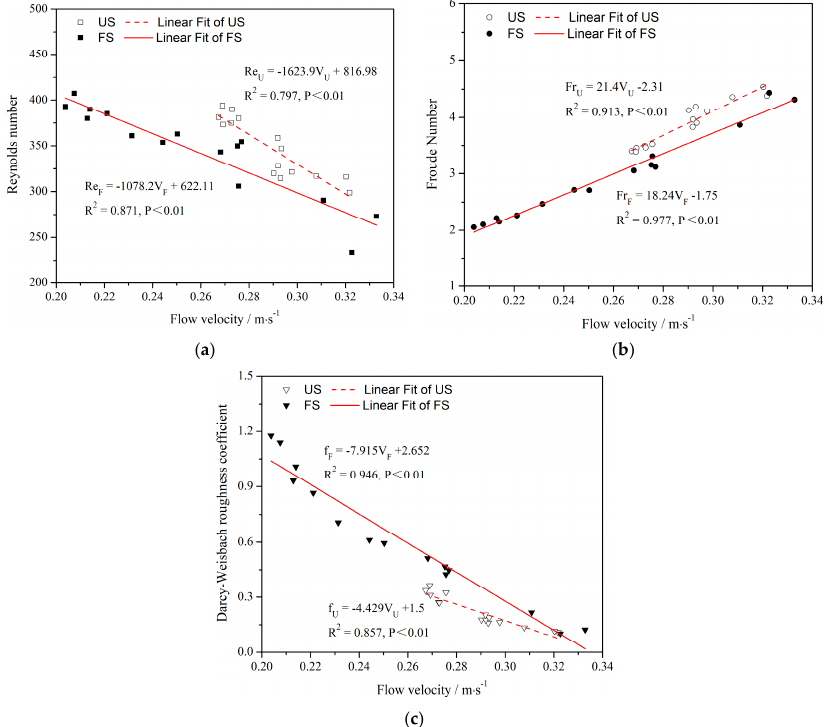
Figure 8. Relationship between flow velocity and hydraulic parameters. ( a ) Re with V, ( b ) Fr with V, ( c ) f with V.